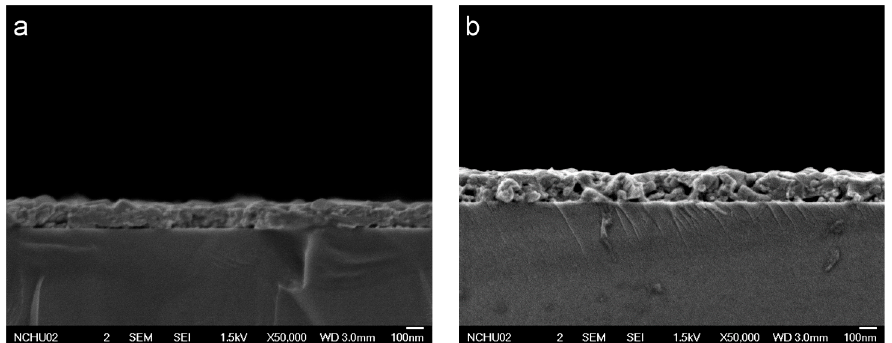
Figure 2. Images of the cross-sectional microstructures of the CuCr 1 − x Zn x O 2 , where x = ( a ) 0 and ( b ) 0.085 of the undoped and heavily doped thin films.